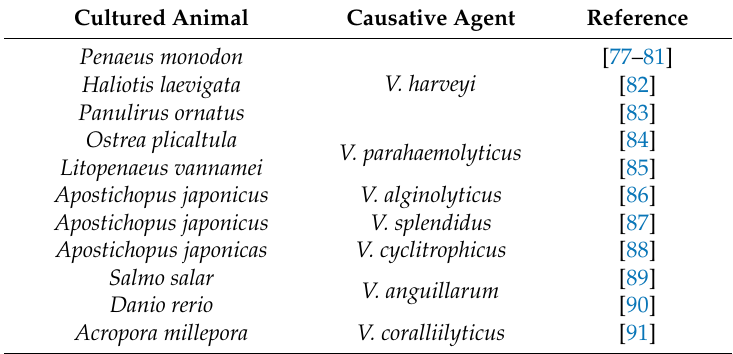
Table 1. Phage therapy trials against causative agents of vibriosis in experimental aquaculture